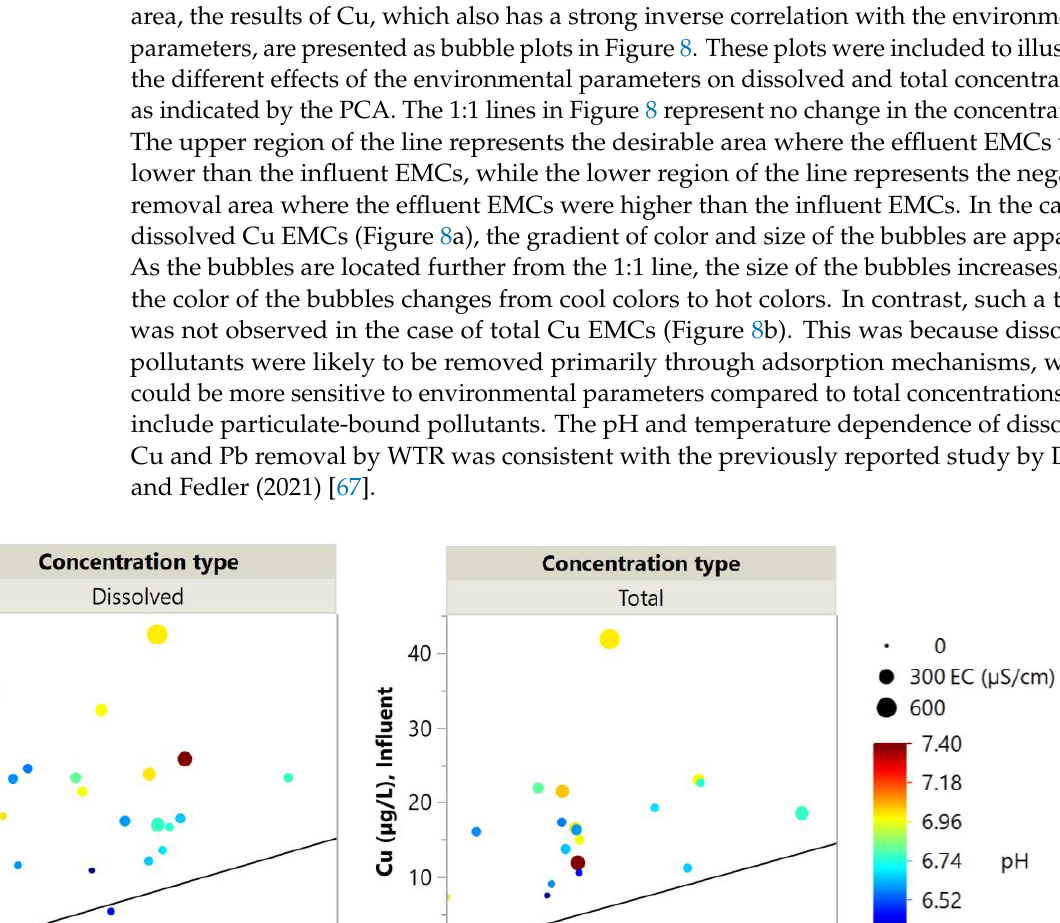
Table 4. Toxicity characteristic leaching values of metals and metalloids measured in spent WTR granules.